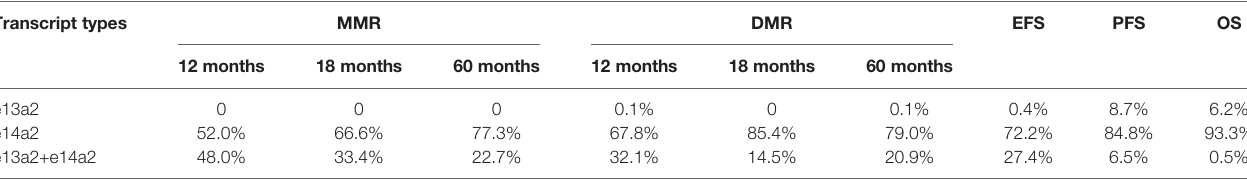
SUCRA, surface under the cumulative